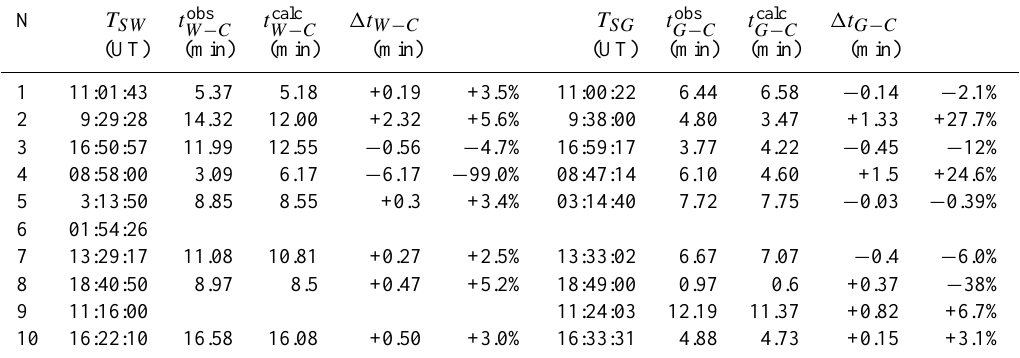
Fig. 14. Results of the fit of Eq. (7) to the magnetic field maximum variance component B ∗ x measured by Cluster C3 for an SI event on 17 August 2001. The solid line in the panel showing the intermediate variance component, B ∗ y , is not a fit but the profile described by Eq. (8) using the parameters determined by the fit to the maximum variance component in the upper panel. Table 4. Timing considerations between WIND-Cluster (W-C) and Geotail-Cluster (G-C). The table shows the event number, time of the shock/pressure jump at Wind ( T SW ) and at Geotail ( T SG ), observed and calculated times of the tail lobe SI at Cluster between the calculated and observed